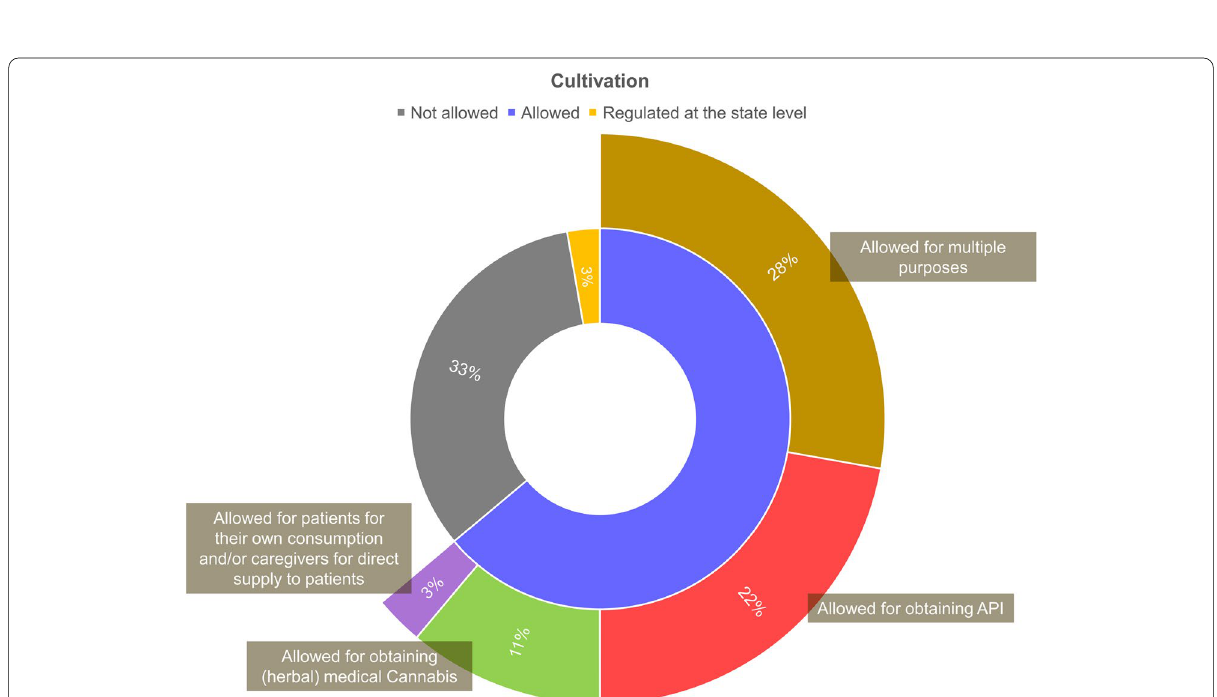
Fig. 4 Classification of the assessed regulatory models with regard to the possibility of medical cannabis cultivation and the purposes of that activity. The classification is based on data obtained from October 2020 to March 2021. API, active pharmaceutical ingredient. The sources of the original information regarding the assessed models are listed in the supplementary